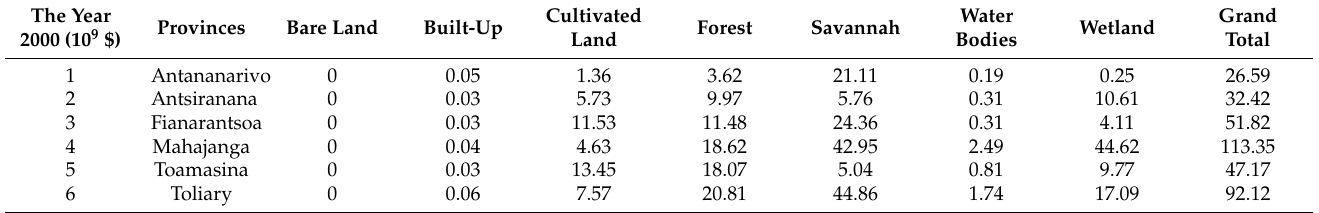
Table 4. Madagascar’s Ecosystem services value (ESV) by land-use type and changes in 2000.